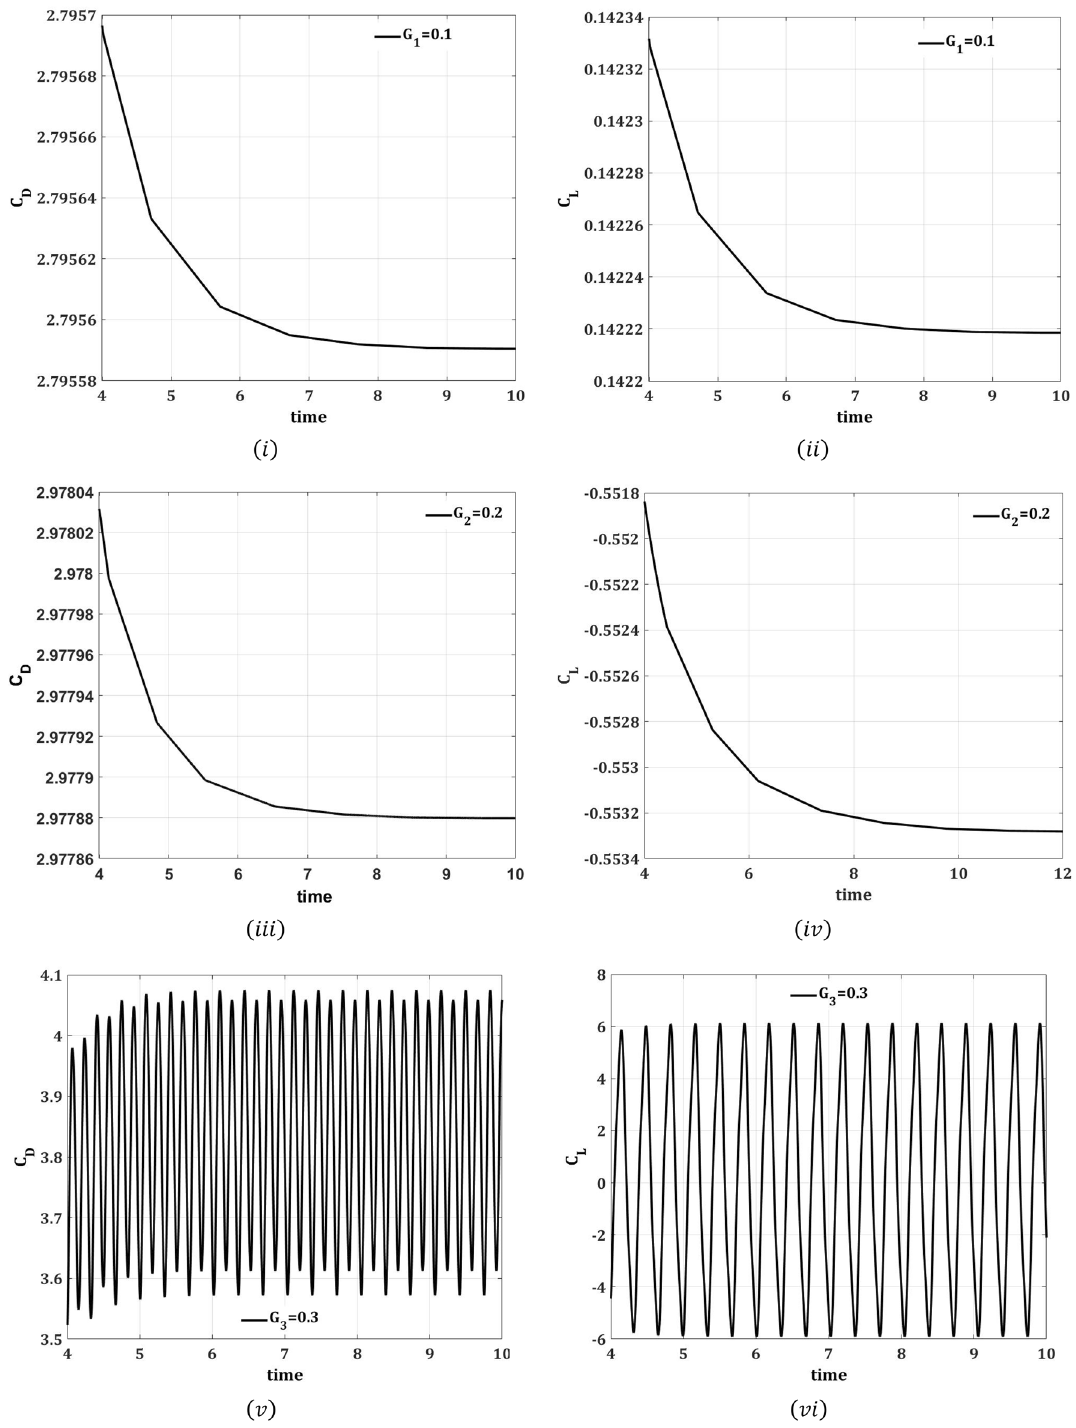
Figure 10. Impact of splitter plate with various gap separations G i , i = 0.1, 0.2, 0.3 on drag coefficient ( C D ) and lift coefficient ( C L ) , w.r.t